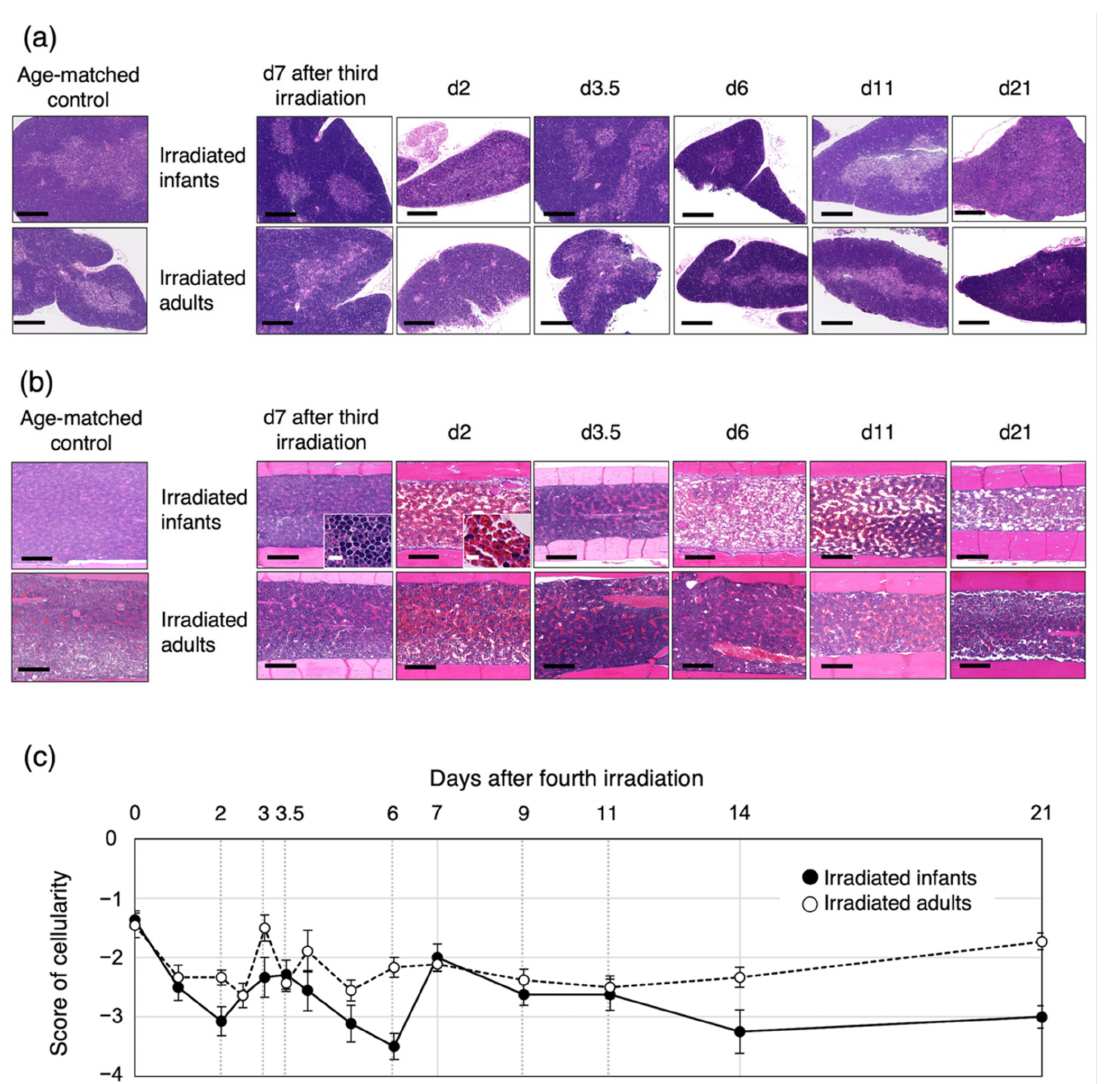
Figure 5. Histological analysis of thymus and femur by hematoxylin and eosin staining in mice irradiated during infancy or adulthood. Representative images of mouse thymus ( a ) and femur ( b ) at 7 days after the third irradiation or at 2, 3.5, 6, 11 or 21 days after the fourth irradiation. Scale bar in all panels represents 250 µ m (10 µ m in each inset). Thymus and femur from mice age at 4 and 11 weeks are shown as age-matched control for the irradiated infants and adults, respectively. The structure of thymic cortex and medulla was completely destroyed at d2. Nucleated cells in bone marrow were almost depleted, and red blood cells were prominent in bone marrow at d2. ( c ) Scoring of the proportion of nucleated cells in bone marrow. Six to fifteen mice were analyzed for each time point. Closed circles, irradiated infant group; open circles, irradiated adult